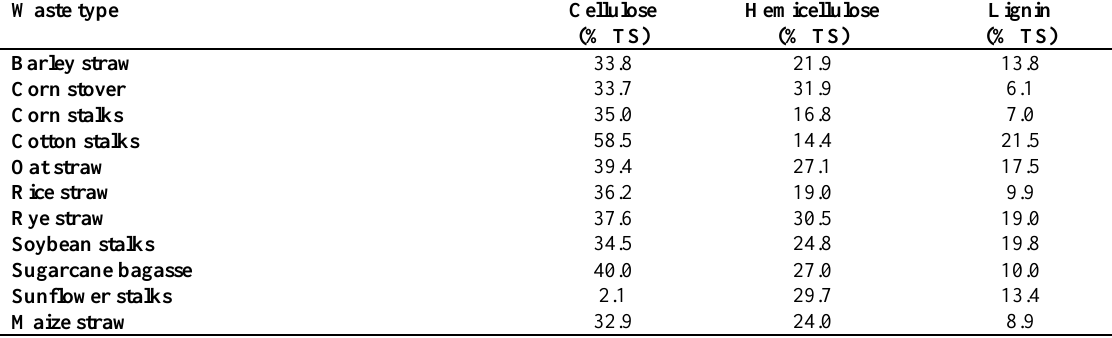
Table 2 Characteristics of lignocellulosic waste from agriculture and agro-industrial sectors Waste